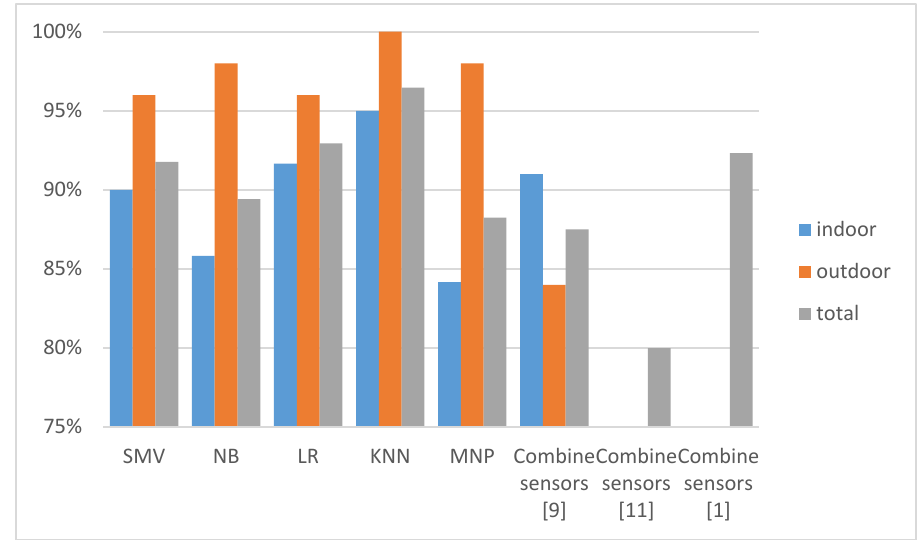
Figure 14. I / O detection accuracy obtained with proposed Figure 14. I/O detection accuracy obtained with proposed preprocessing. Figure 14. I/O detection accuracy obtained with proposed preprocessing.